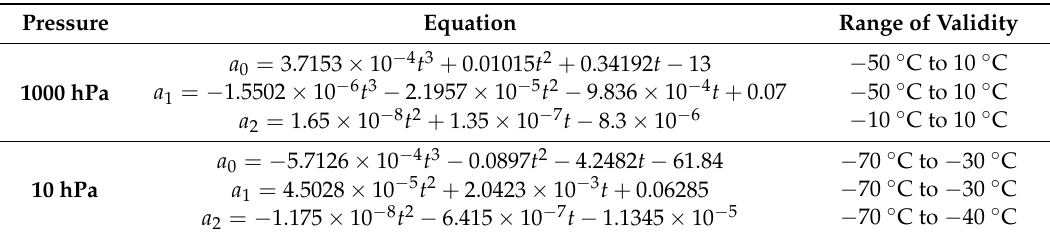
Table 3. Polynomial regression fit equations of the curves shown in Figure 3a–c.